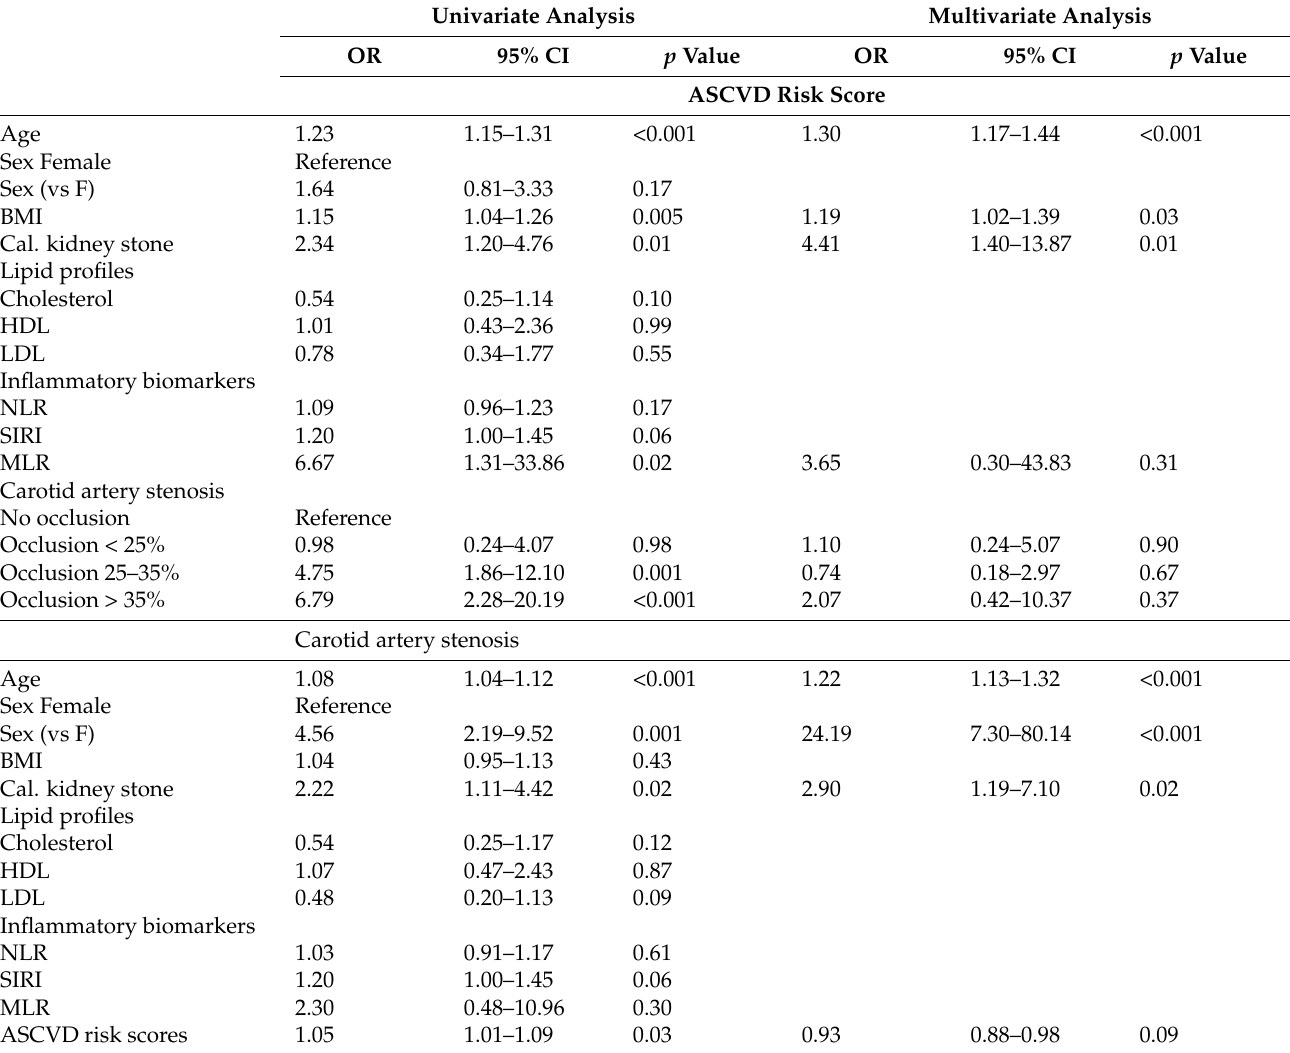
Table 3. Logistic regression analysis for predictors of high ASCVD risk score and carotid artery stenosis. Univariate Analysis Multivariate